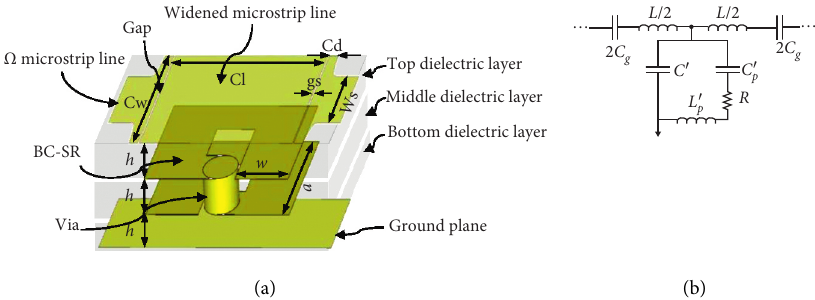
Figure 2: The DNG cell including a BC-SR electrically loaded to a microstrip line with series gaps: (a) a 3D layout and (b) the lumped element equivalent circuit.